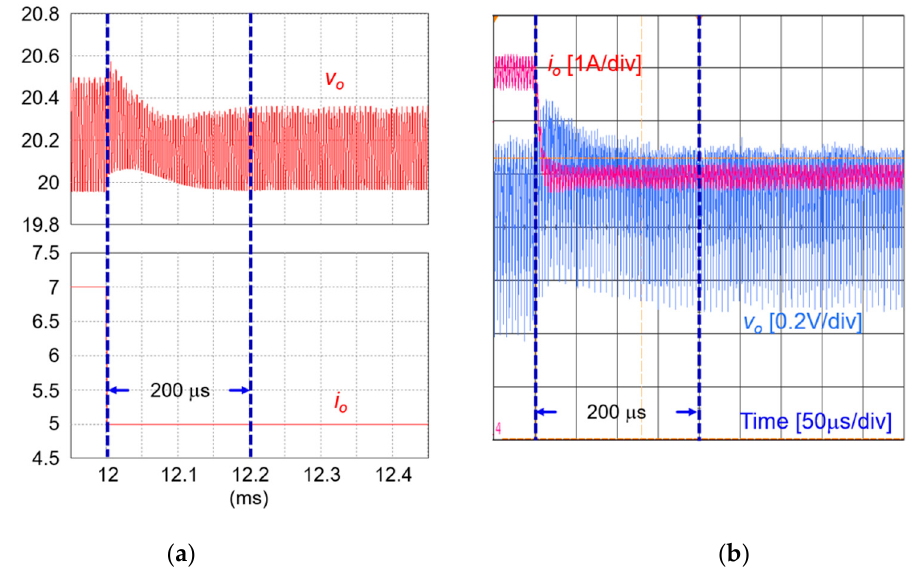
Figure 22. Transient response of load change from 70% to 50% with the mismatched secondary side leakage inductances and the flux-balance loop control ( a ) simulation results and ( b ) experiment results.